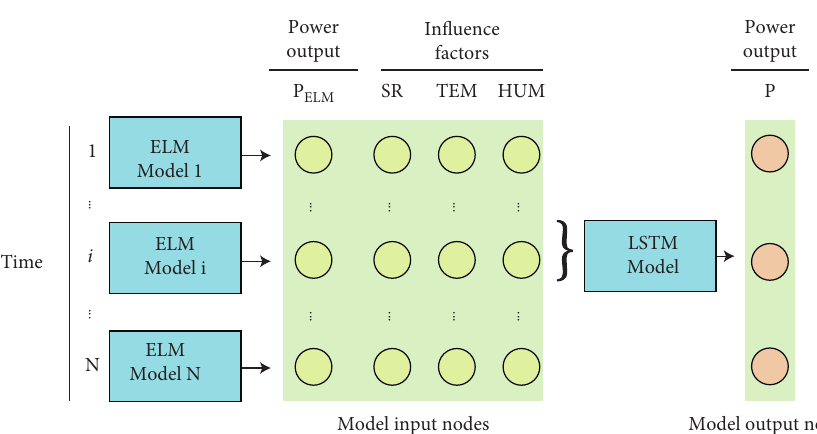
Figure 8: The single-model multivariable LSTM forecasting model of the forecasting